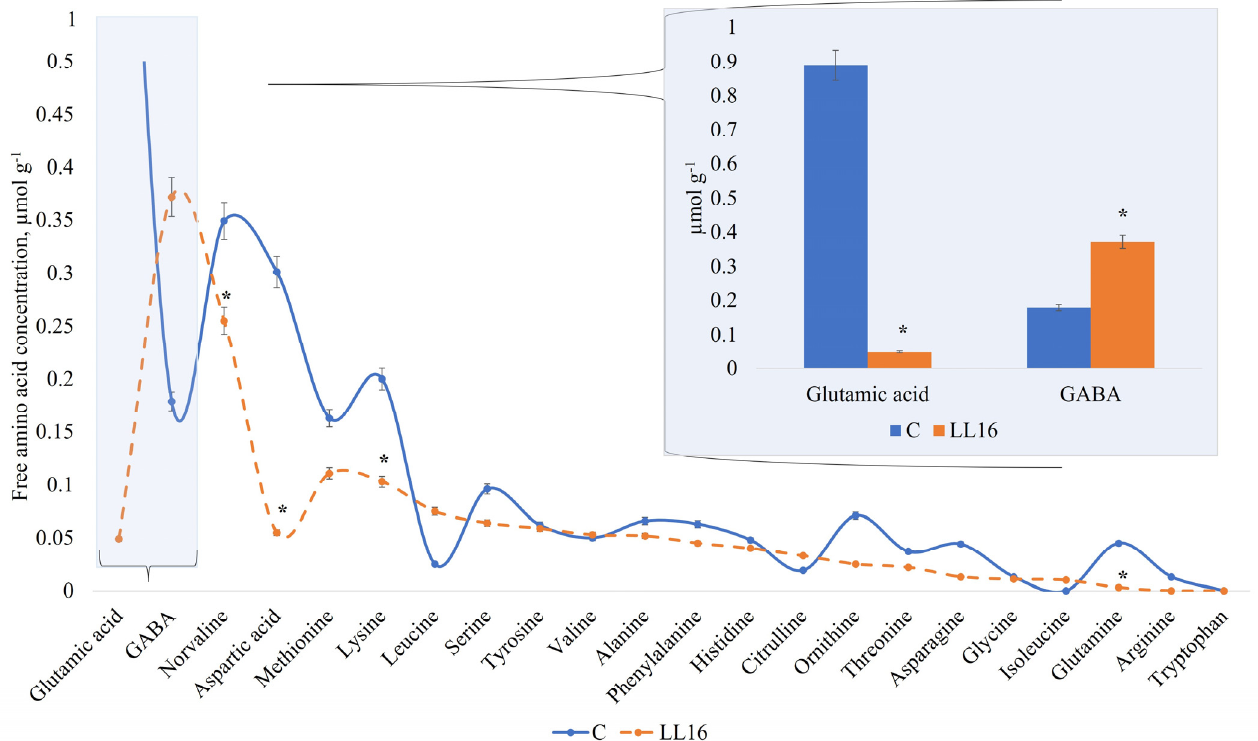
Figure 4. Free amino acid concentration ( µ mol g − 1 ) in an experimental milk matrix with Lactococcus lactis strain LL16 and commercial starter (C) after 24 h of fermentation at 37 ◦ C. Statistically significant di ff erences ( p < 0.05) are indicated by (*).